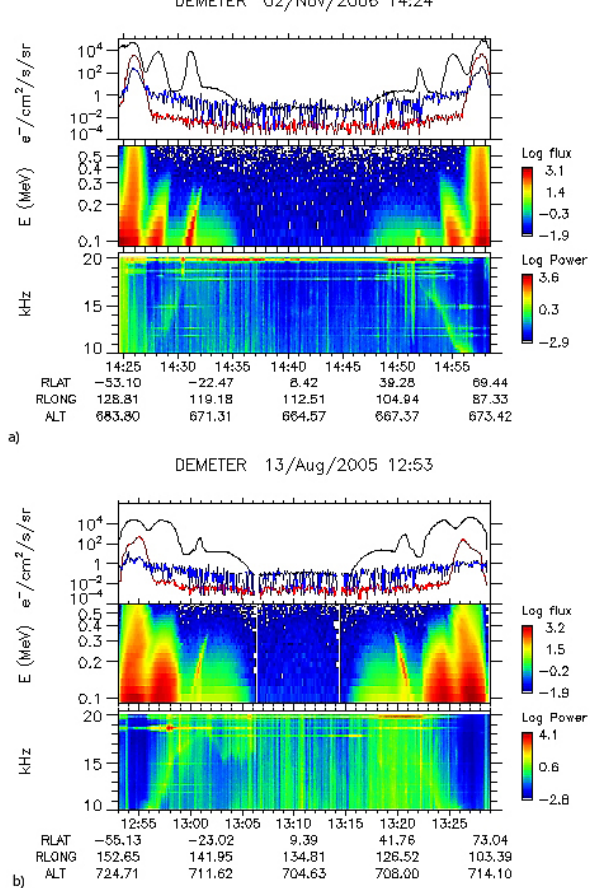
Fig. 1. (a) Energetic electrons and wave data along a half-orbit on 2 November 2006. The top panel gives the variations in the electron fluxes in three energy ranges (90–526keV, 526–971keV and 971– 2350keV). The middle panel shows the electron energy time spec- trogram and the bottom panel gives the frequency–time spectrogram of the electric component of the VLF waves in the frequency range from 10 to 20kHz. (b) Same as (a) for a pass on 13 August